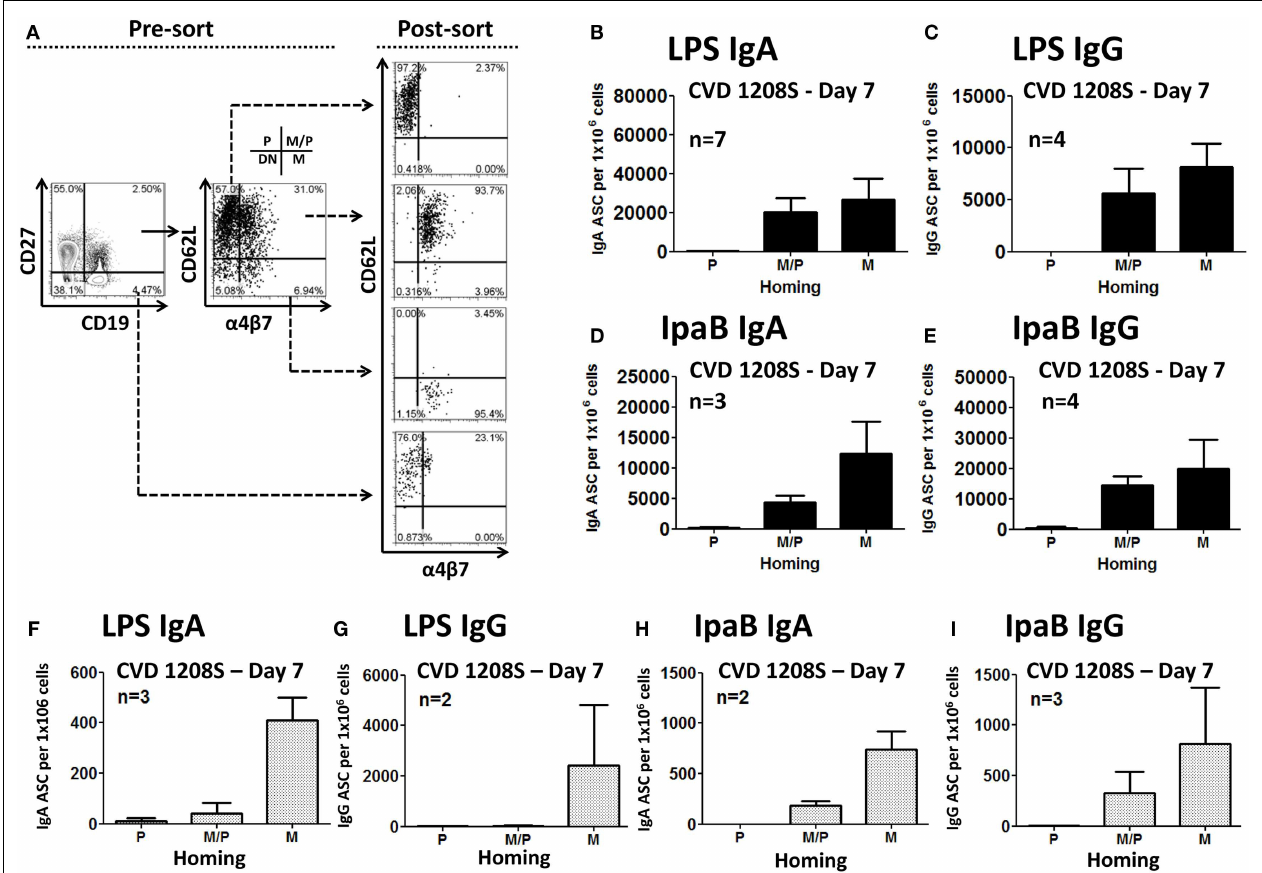
co-expression of integrin α 4 β 7 and CD62L. DN cells, which did not express either integrin α 4 β 7 or CD62L, were not sorted. Sorted cells were assayed for antibody production by ELISpot in plates coated with LPS or IpaB. Anti-LPS IgA (B) and IgG (C) ASC were identified in cells homing to